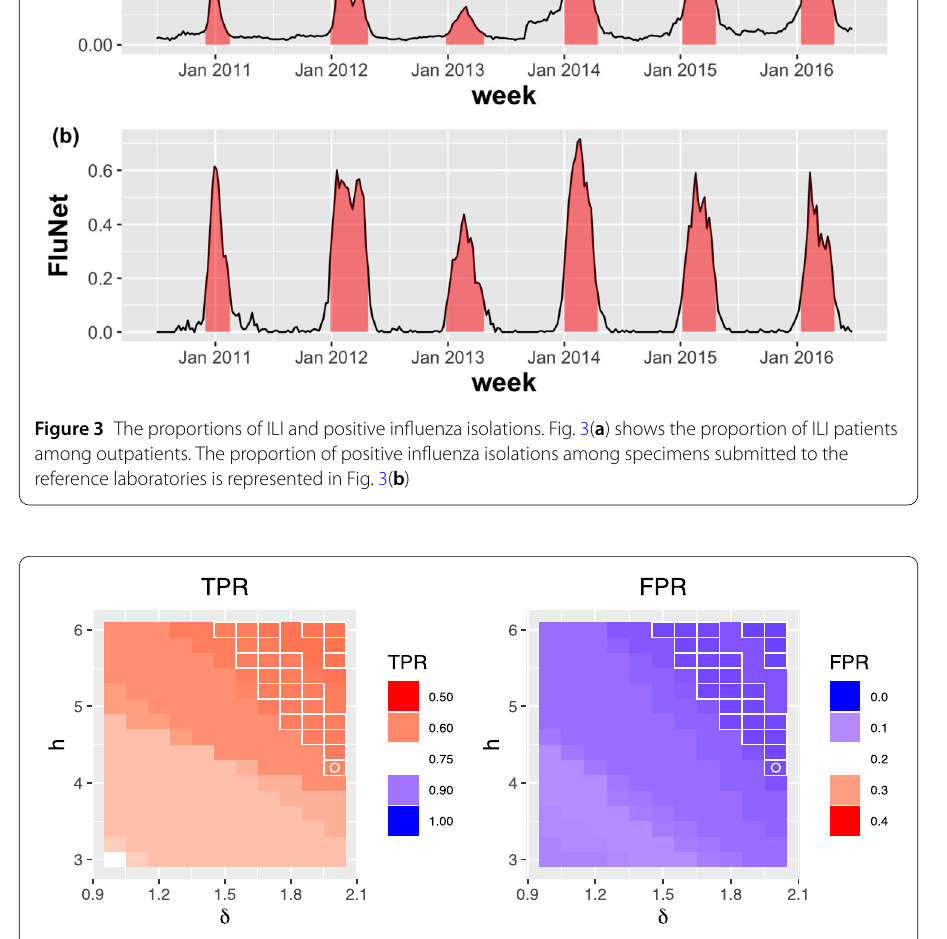
Figure 4 The TPR and FPR for the CUSUM. We show the TPR and FPR as a function of δ and h . Here, white boxes represent the parameter values where FPR ≤ 0.05, and the white circle indicates the maximum of TPR among FPR ≤